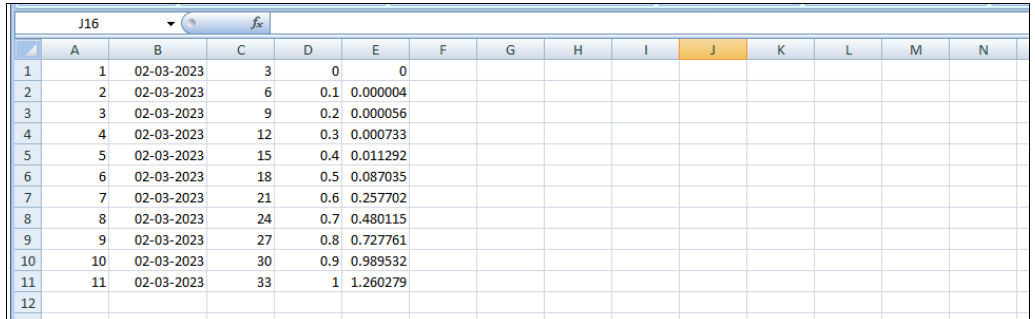
Figure 3: Screenshot of the data file (DataFile_1.csv) displayed within the Excel sheet after completing the first round of data acquisition in Loop-1 by the programme